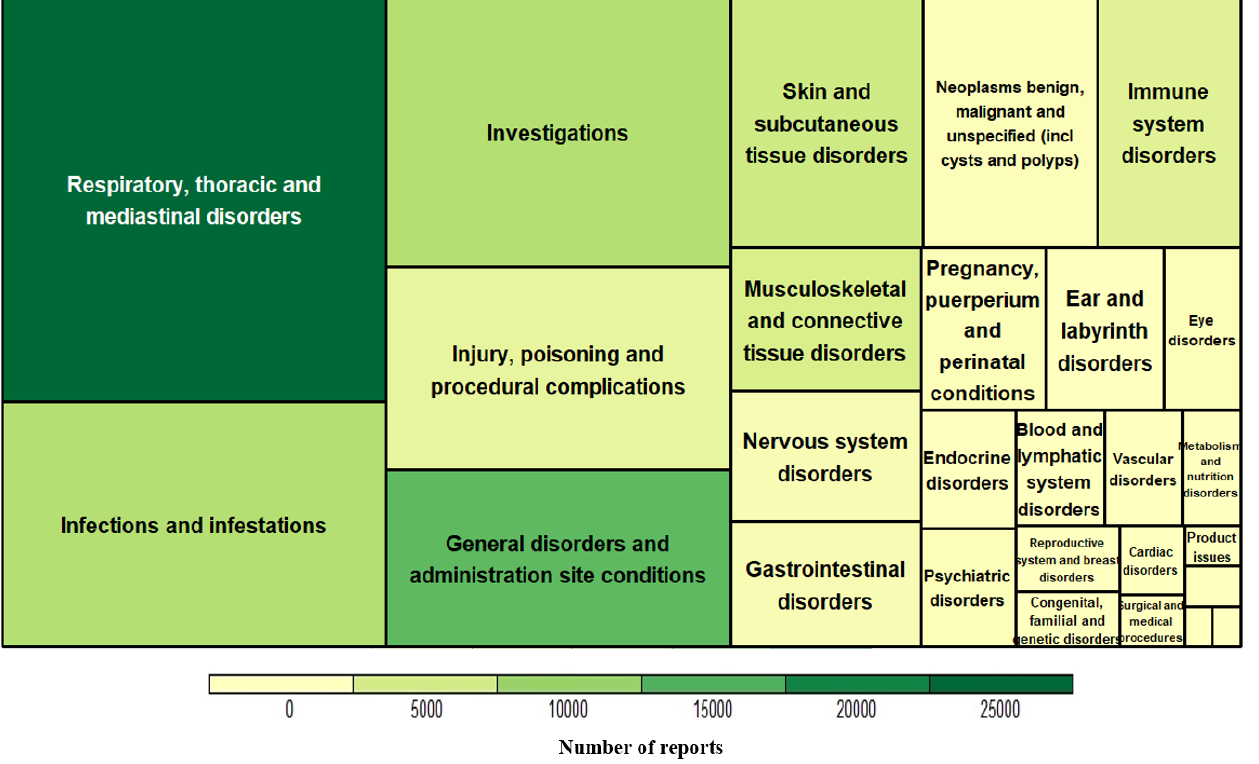
Figure 1. Treemap of signals for omalizumab by system organ class.